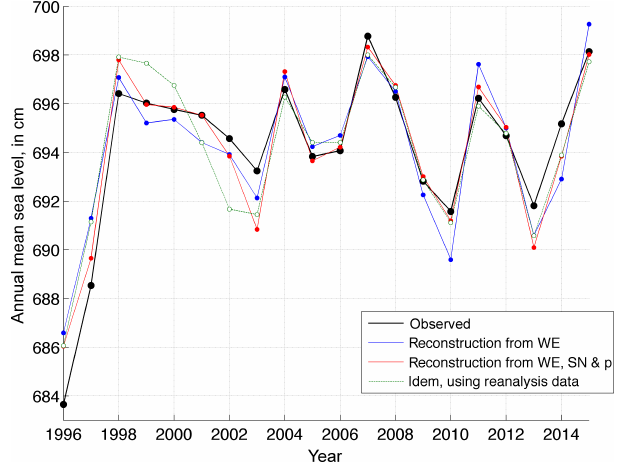
Figure 8. Observed annual mean sea level at Den Helder is repli- cated in black from Fig. 2. The blue and red lines represent recon- structed annual mean sea levels based on atmospheric data. The blue line results from the annual mean west–east component of wind en- ergy combined with the least squares fit of Fig. 7. The red line uses a multiple regression involving both directions of the wind energy vector (i.e., west–east and south–north) as well as the annual mean atmospheric pressure at Vlieland weather station. The green dashed line is a reconstruction based on reanalysis